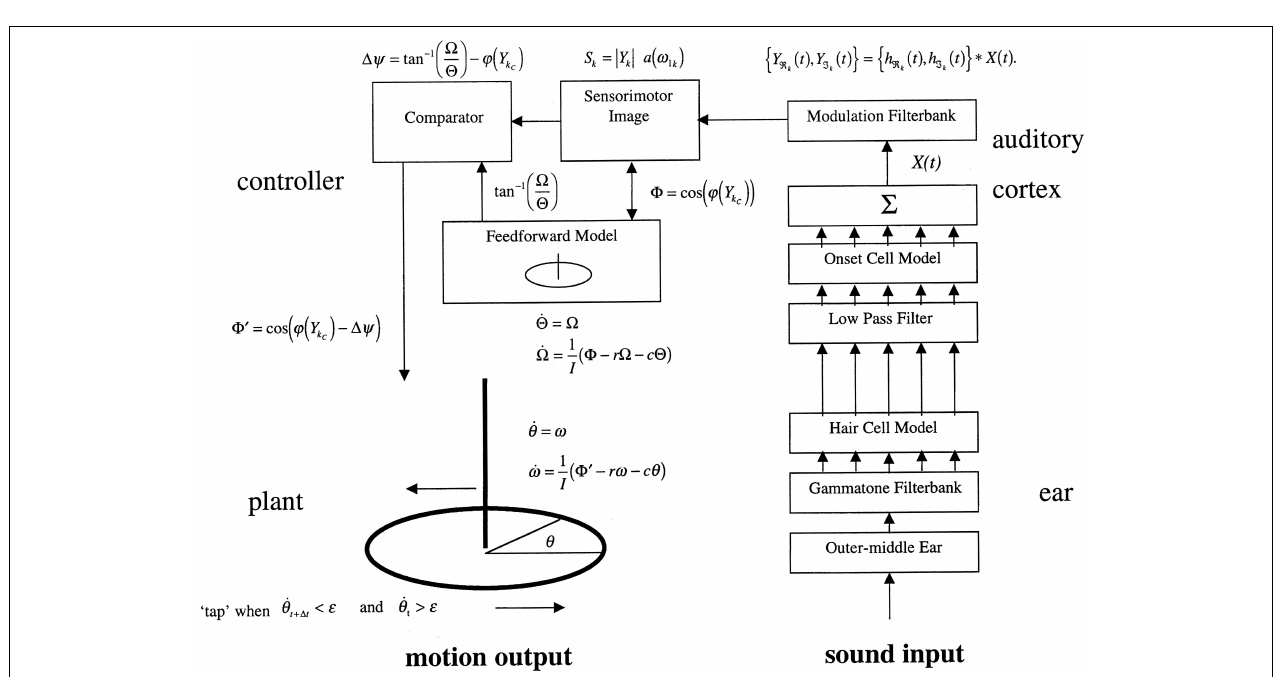
FIGURE 4 | A reproduction of Figure 2 from Todd et al. (2002) illustrating the principal brain representations and their connections according to the neurobiological theory of temporal tracking and beat induction. (1) The plant, (2) the sensory processing system, (3) the